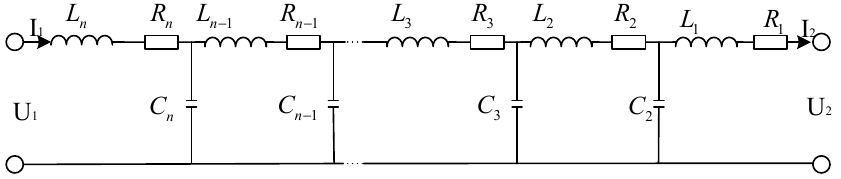
Figure 2. Equivalent model of distributed parameter circuit.